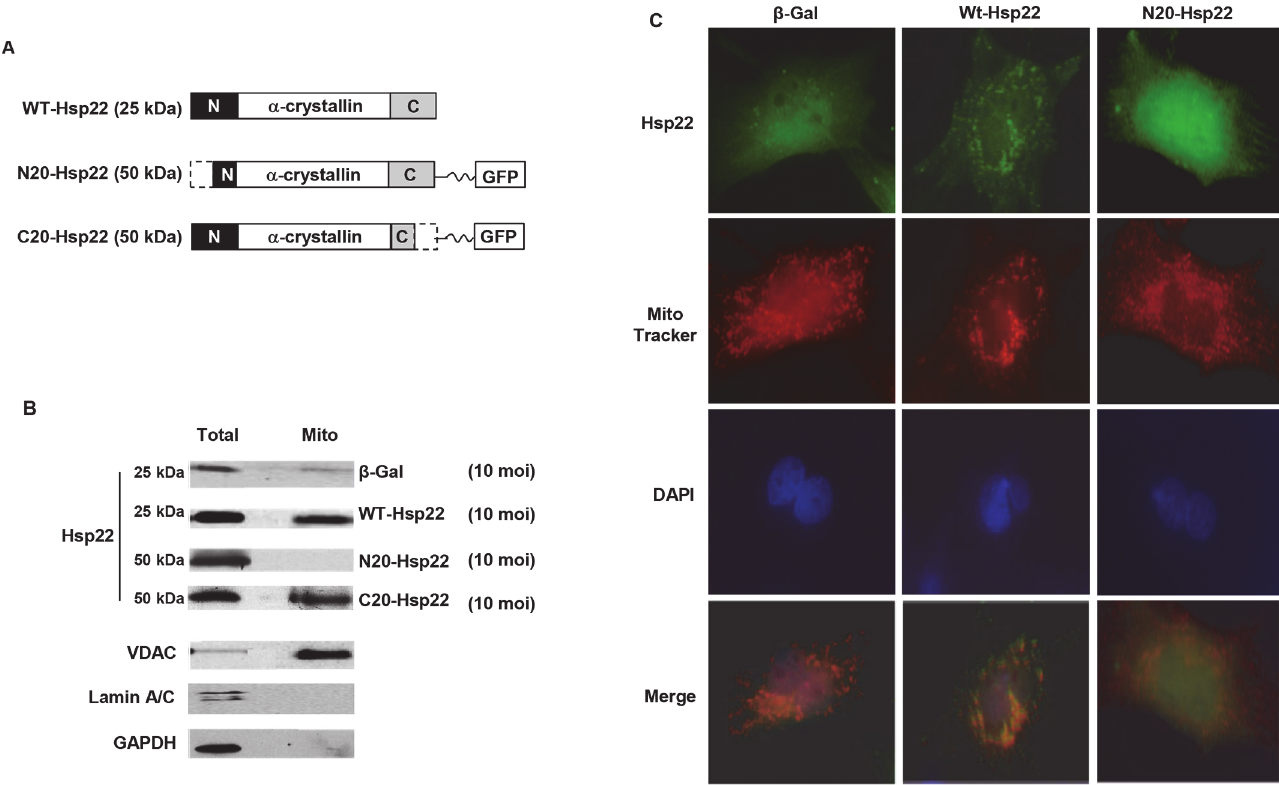
Fig 2. N-terminal deletion of the Hsp22 coding sequence prevents its mitochondrial localization. A. Hsp22 mutants were generated by deletion of 20 amino acids at either the N-terminus (Ad-N20-Hsp22) or C-terminus (Ad-C20-Hsp22), respectively, from the Hsp22 WT coding sequence (Ad-WT-Hsp22). B. Examples of the ratio of Hsp22 between the mitochondrial fraction and the total protein extract for the corresponding protein extracted from cardiac myocytes treated with β -Gal, WT-Hsp22, N20-Hsp22 and C20-Hsp22 adenoviruses (10 moi). Markers include VDAC (mitochondria), lamin A/C (nucleus), and GAPDH (total extracts). C. Immunofluorescence on myocytes infected with 10 moi β -Gals, Ad-WT-Hsp22 and Ad-N20-Hsp22. Staining is performed with Hsp22 or GFP antibodies (green), Mitotracker (red) and nuclear DAPI counterstaining (blue), followed by merging of the three